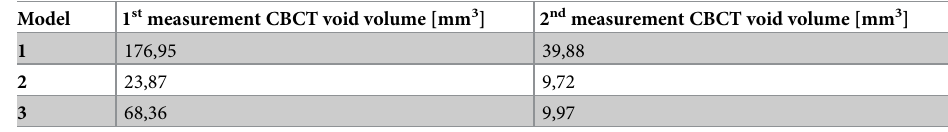
Table 2. Void volume measurements small-defect